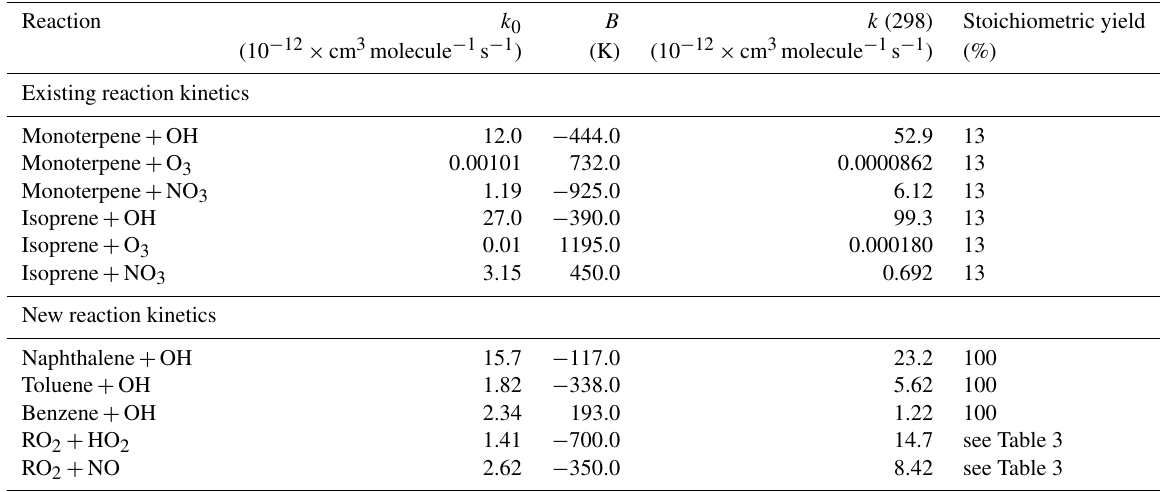
Table 1. Kinetic parameters used to calculate rate coefficient (Eq. 1) for both existing and new SOA precursors, taken from Atkinson and Arey (2003). Note, VOC ANT / BB reacts with OH with reaction kinetics based on either monoterpene, naphthalene, toluene, or benzene. Reaction